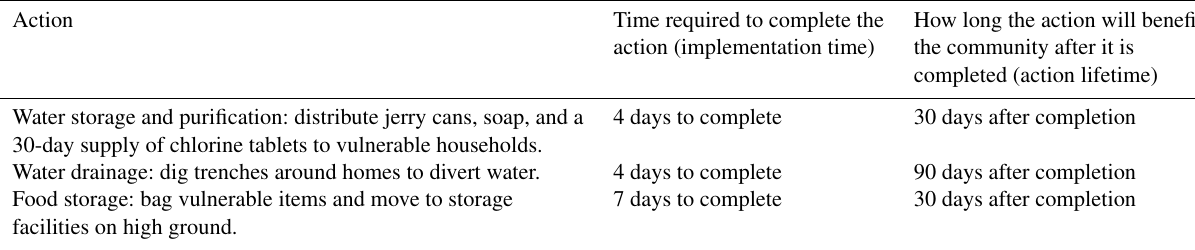
Table 1. Actions selected for a forecast-based financing system. See Jongman et al. (2015) for more information on the actions and their associated costs. Note that the implementation time of an action should equal the lead time of the forecast selected to trigger that action. Action Time required to complete the How long the action will benefit action (implementation time) the community after it is completed (action lifetime) Water storage and purification: distribute jerry cans, soap, and a 4 days to complete 30 days after